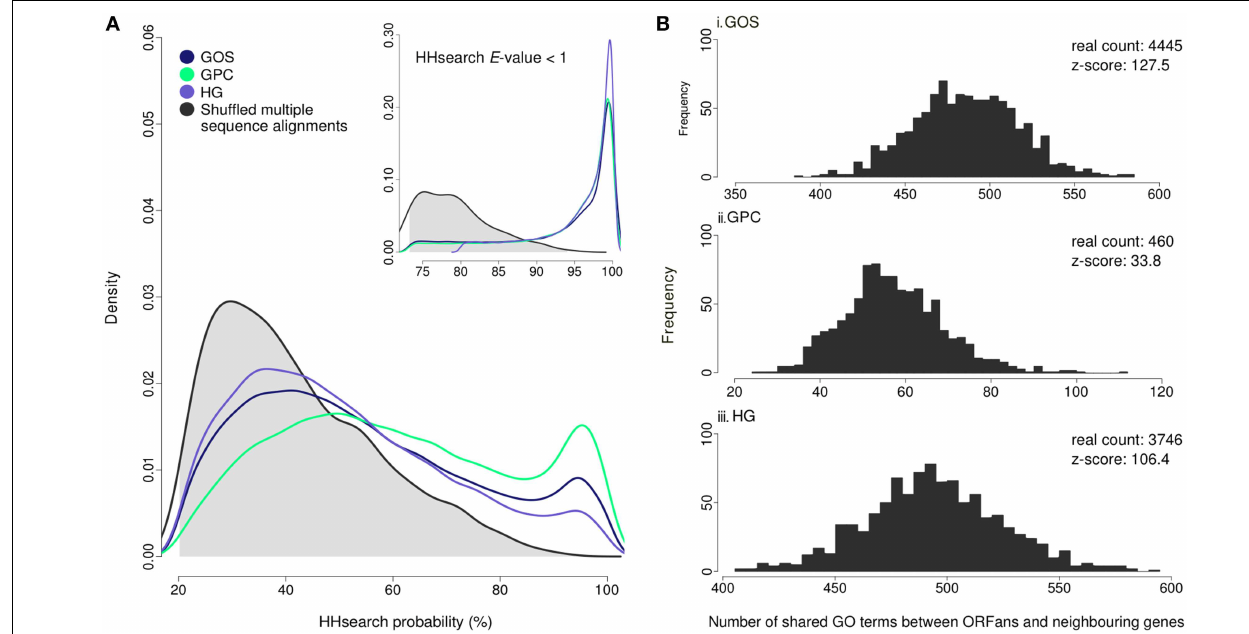
FIGURE 2 | Estimated false discovery rate of ORFan remote homology detection and functional prediction. (A) Distributions of HHsearch probability scores for ORFans from three metagenomes, and shuffled sequences, searched against a PDB-derived HMM library. There is an abundance of high-scoring predictions (i.e., above 80% probability) for ORFan proteins compared to the expected (null) distribution. This separation becomes even greater when an HHsearch E -value threshold of 1 is applied